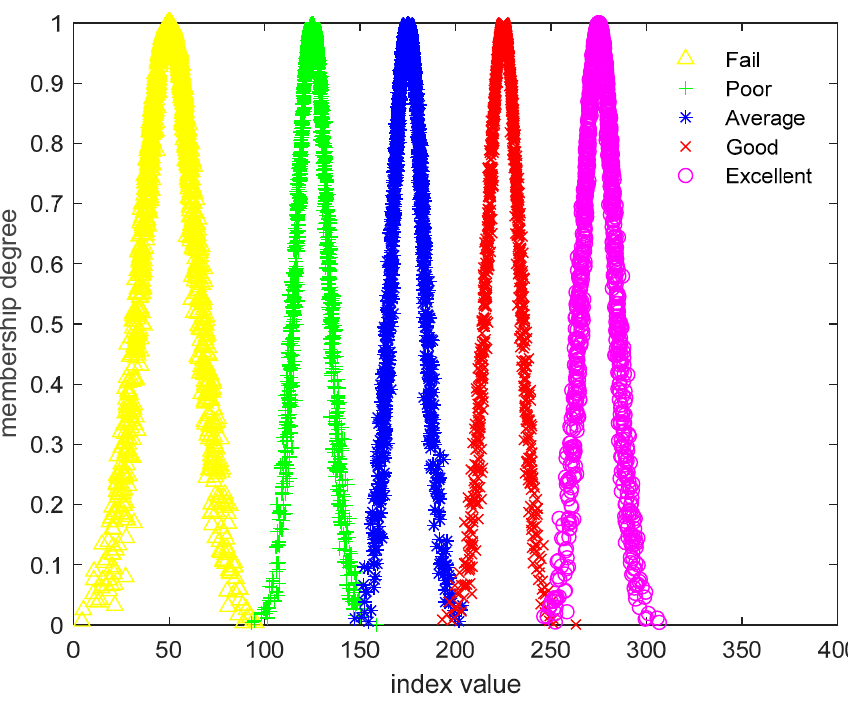
Figure 6. Cloud drop chart of indicator I 6 .